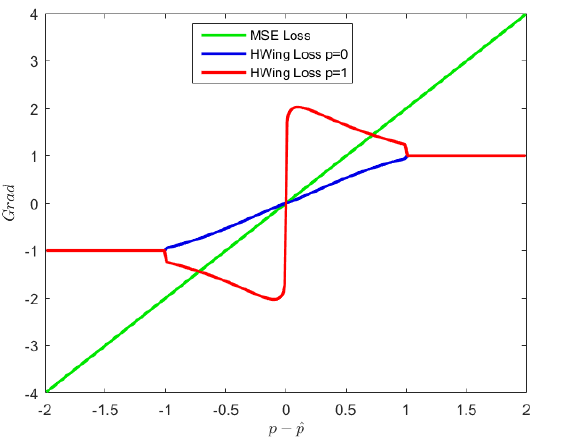
Figure 5. Gradient of Heatmap Wing Loss and MSE